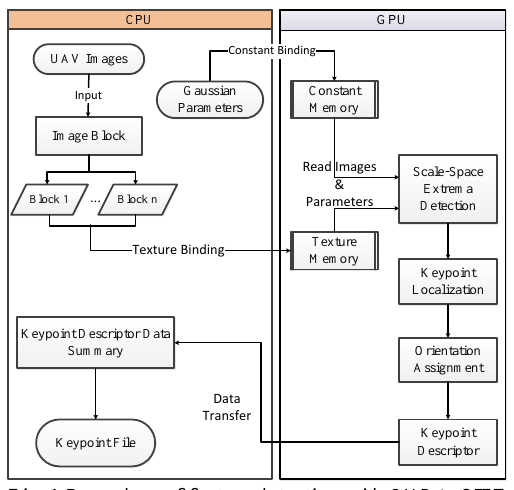
Fig. 1 Procedure of feature detection with